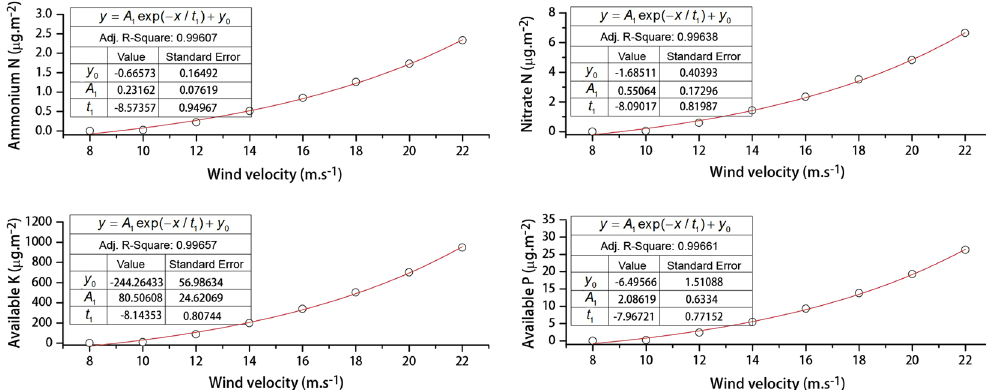
Figure 5. Nutrient loss under different wind velocities.